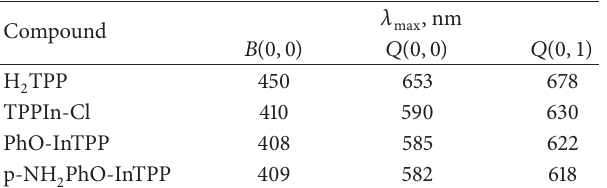
Table 1: Summary of the fluorescence band maxima at 23 K in